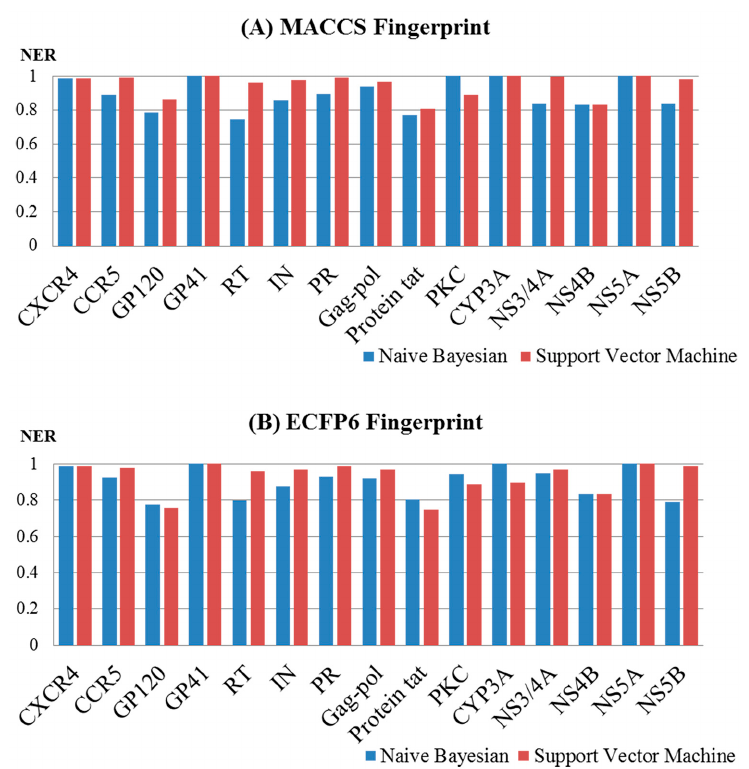
Figure 5. Performance of the 60 multiple QSAR models built based on MACCS ( A ) and ECFP6 ( B ) using different algorithms determined by test set